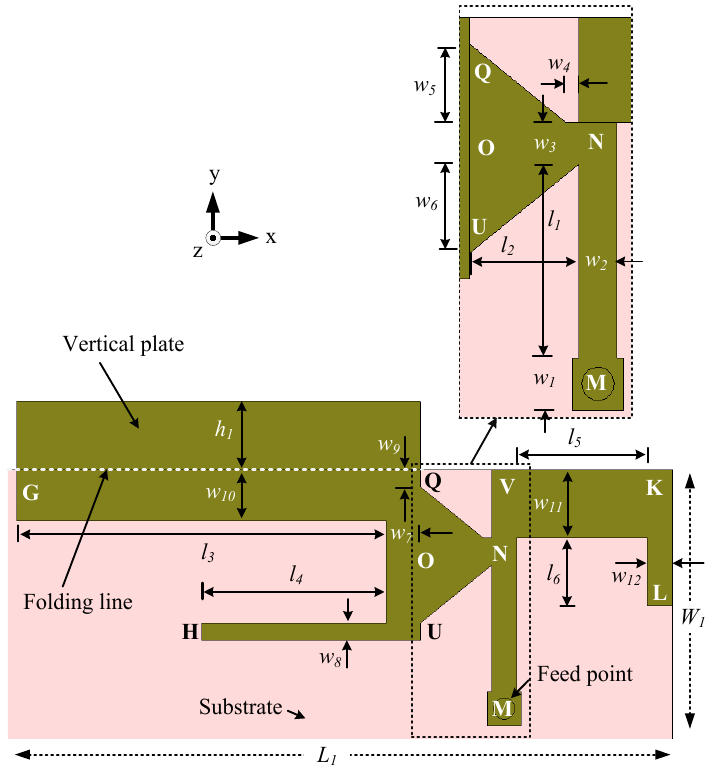
Figure 6. Configuration of the dual-band antenna (Ant#2) for the mid (1427–2690 MHZ) and high (3300–3800 MHz) bands. For better presentation, the vertical plate is unfolded along the +y-axis. This antenna is composed of three elements: an L-shaped element MNO in the middle, a U-shaped large element GQUH loaded with the vertical plate on the left, and an L-shaped element VKL on the right. Here, the vertical plate is aligned with the edge GQ. The dimensions are optimized using a parameter analysis conducted in CST for good impedance matching. The optimized design parameters of the dual-band antenna (Ant#2) are listed in